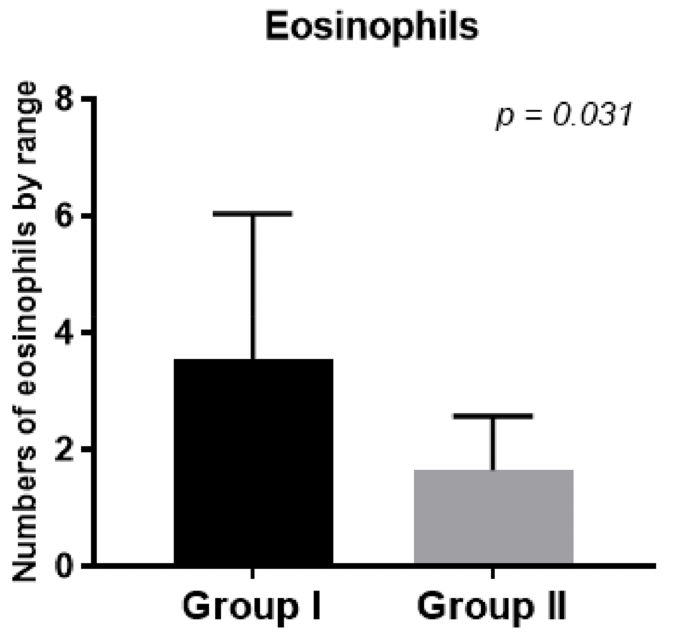
Figure 5. Eosinophil numbers in tissues collected during FESS in groups 1 and